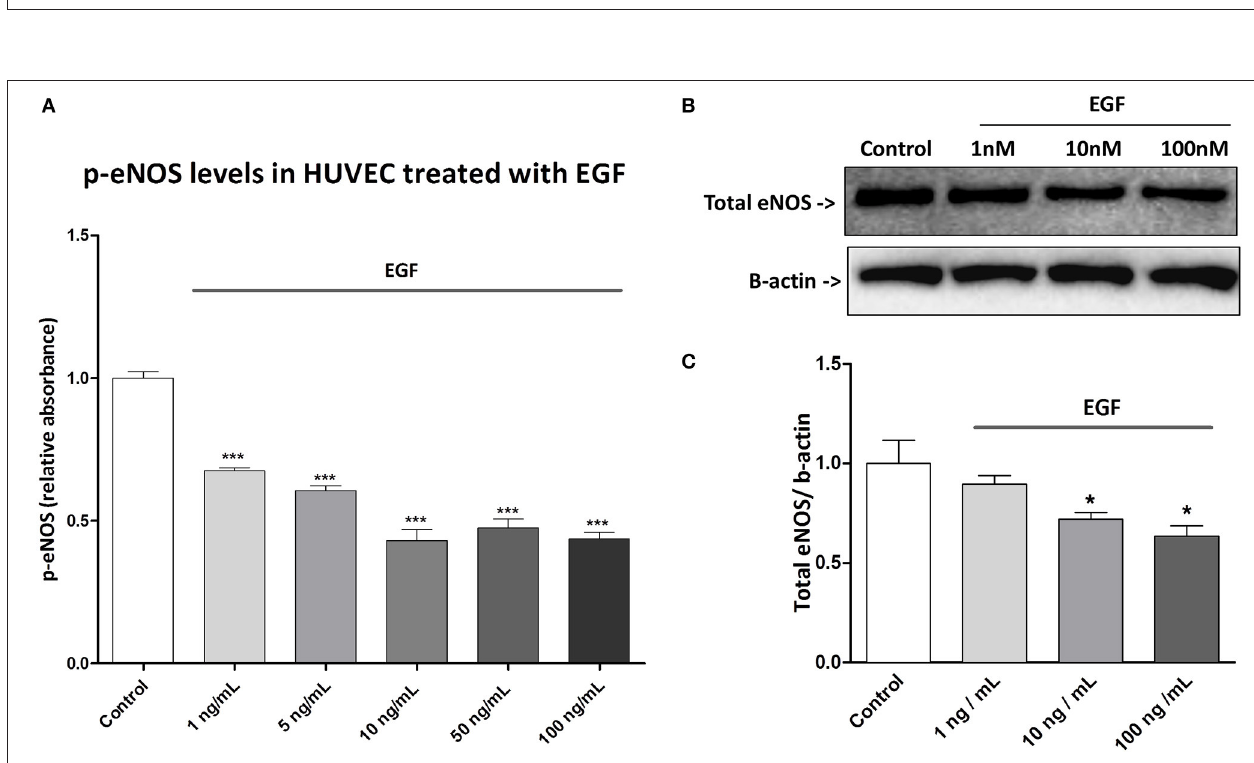
FIGURE 6 | Effect of exogenous EGF in HUVEC. (A) HUVECs were treated for 48h with different concentrations of EGF ant then were lysed. Proteins were quantified by BCA assay and 10 µ g of protein were used for each well in the ELISA. p-eNOS levels were expressed as absorbance (OD) at 450nm. Results are expressed as mean ± SD of three independent experiments. *** P < 0.001 (comparison between control and treatment). (B) HUVECs were treated for 48h with EGF. Lysates were electrophoresed and immunoblotted with total eNOS antibody, β -actin antibody was used to ensure equal loading. Images are representative of one of three independent experiments. (C) Densitometric analysis of western blot. * P < 0.05 (comparison between control and treatments).